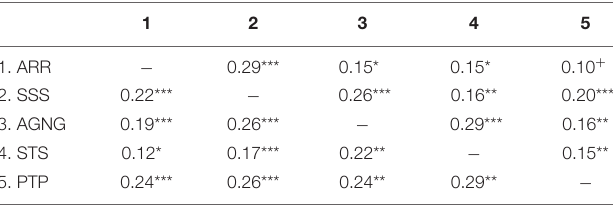
TABLE 4 | Correlations among individual executive function tasks at pretest and posttest.